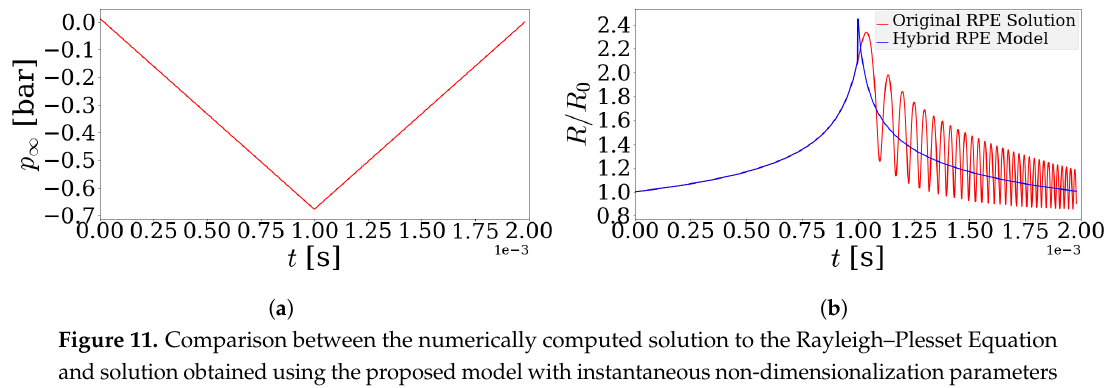
Figure 11. Comparison between the numerically computed solution to the Rayleigh–Plesset Equation and solution obtained using the proposed model with instantaneous non-dimensionalization parameters in ( b ), based on a forced linear pressure variation at a distance from the bubble interface shown in ( a